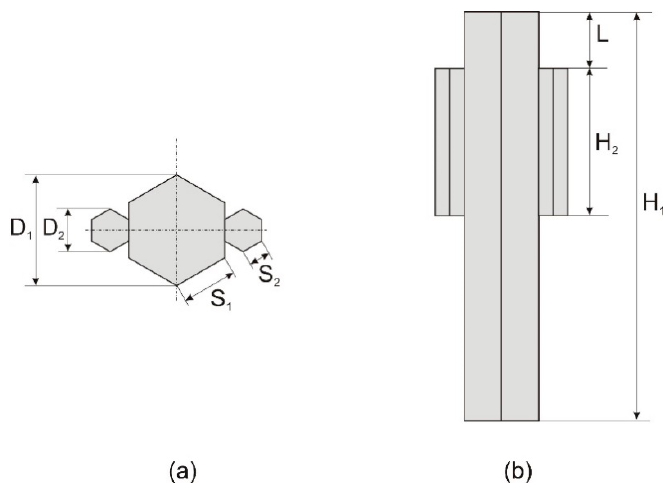
Figure 5. Geometry of the simplified human body model in the XGtd™ program: ( a ) Top view; ( b ) Front view.